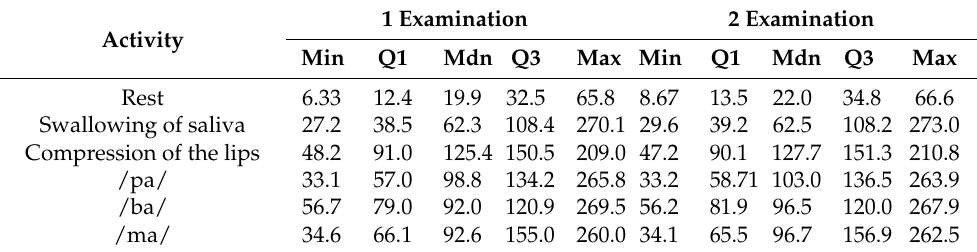
Table 2. EMG values of the study on repeatability of the recording protocol. Activity